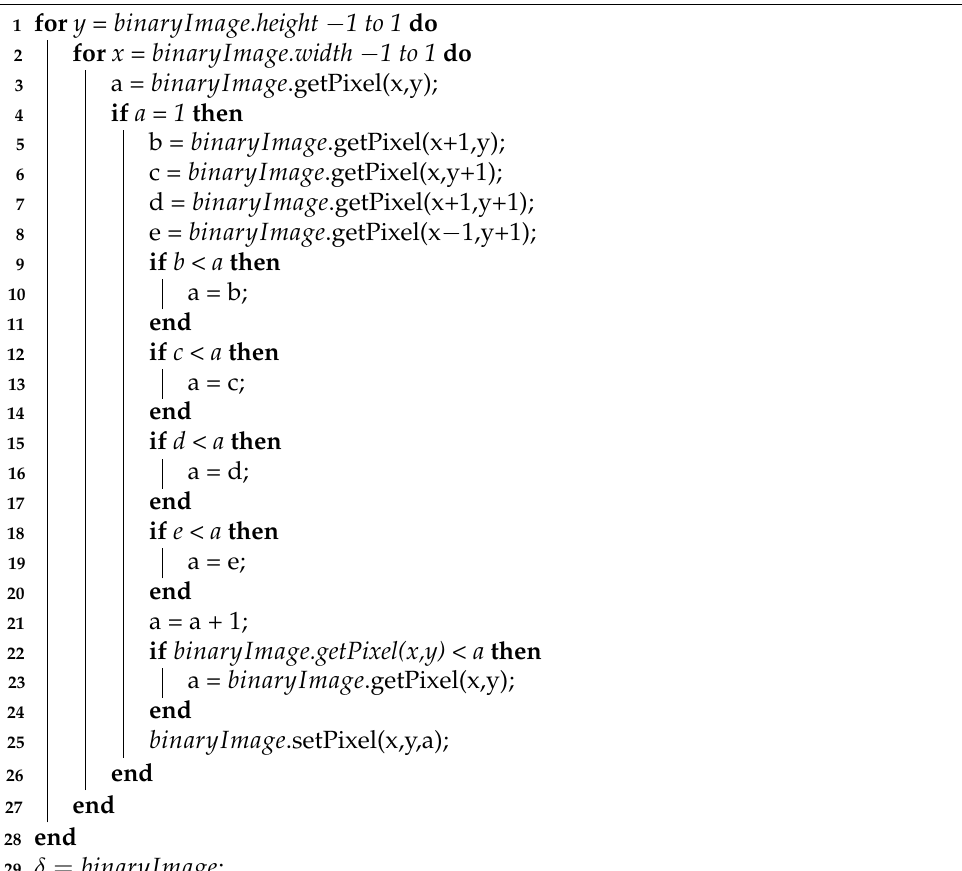
Algorithm 2 FDT algorithm second step with the d 8